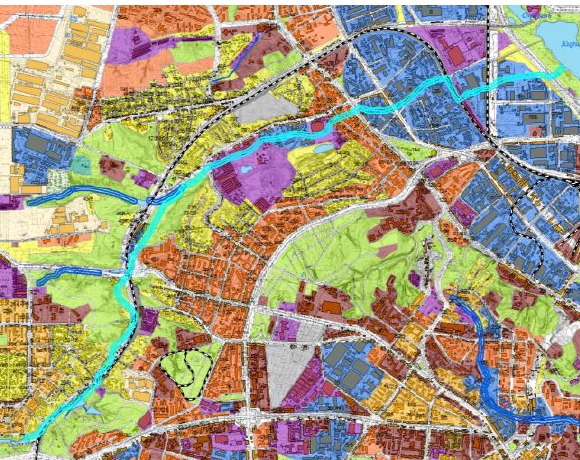
Figure 2. The Sirets river (marked by blue colour) is compared with the functional use types of the city territory (according to the General Plan till 2020). The purple colour indicates the communal and warehouse territories, blue – industrial, green – green areas of general use.